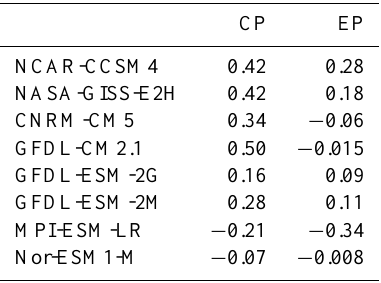
Table 1. Pattern correlations of runoff between the selected models and CP-/EP-El Niño years.